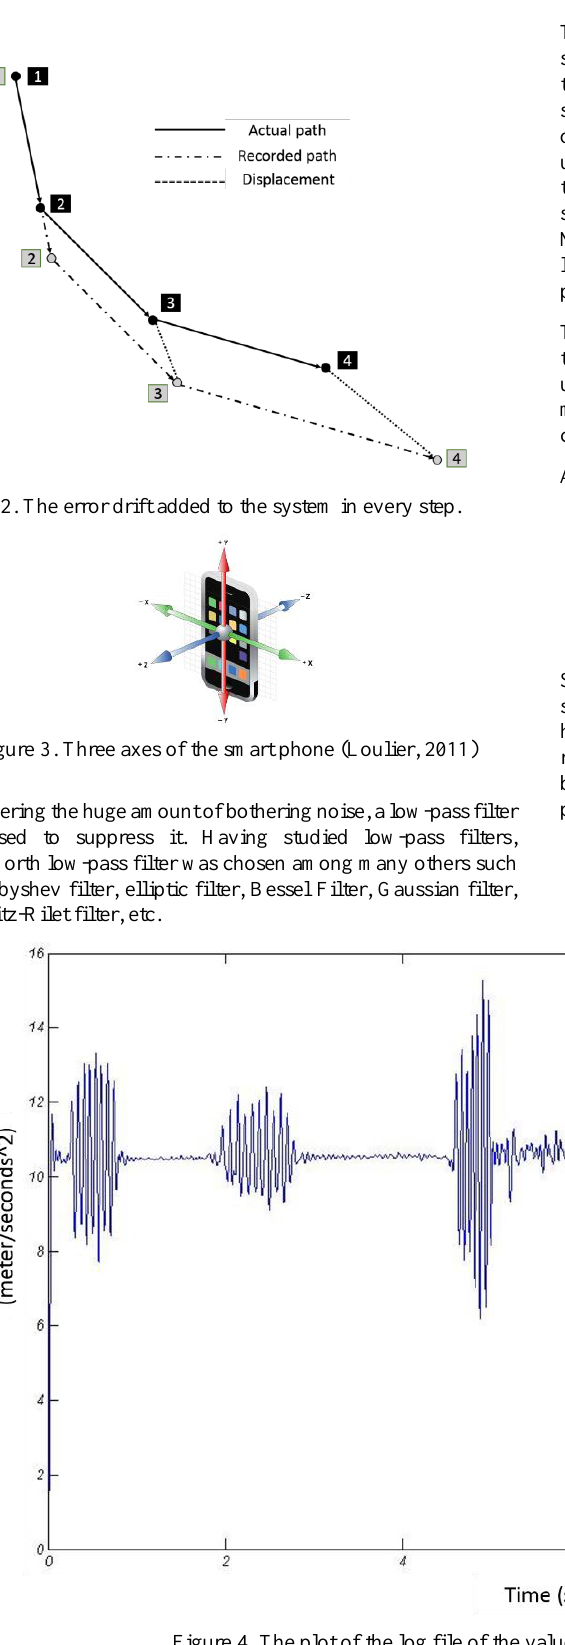
Figure 4. The plot of the log file of the value parameters calculated in Equation